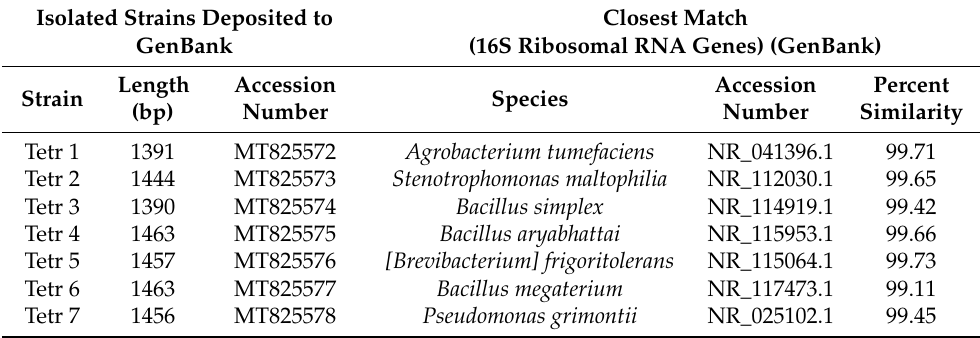
Table 1. Sequence similarities of endophytic bacteria isolated from the root system of Tetragonia tetragonioides (Pall.) Kuntze with sequences registered in